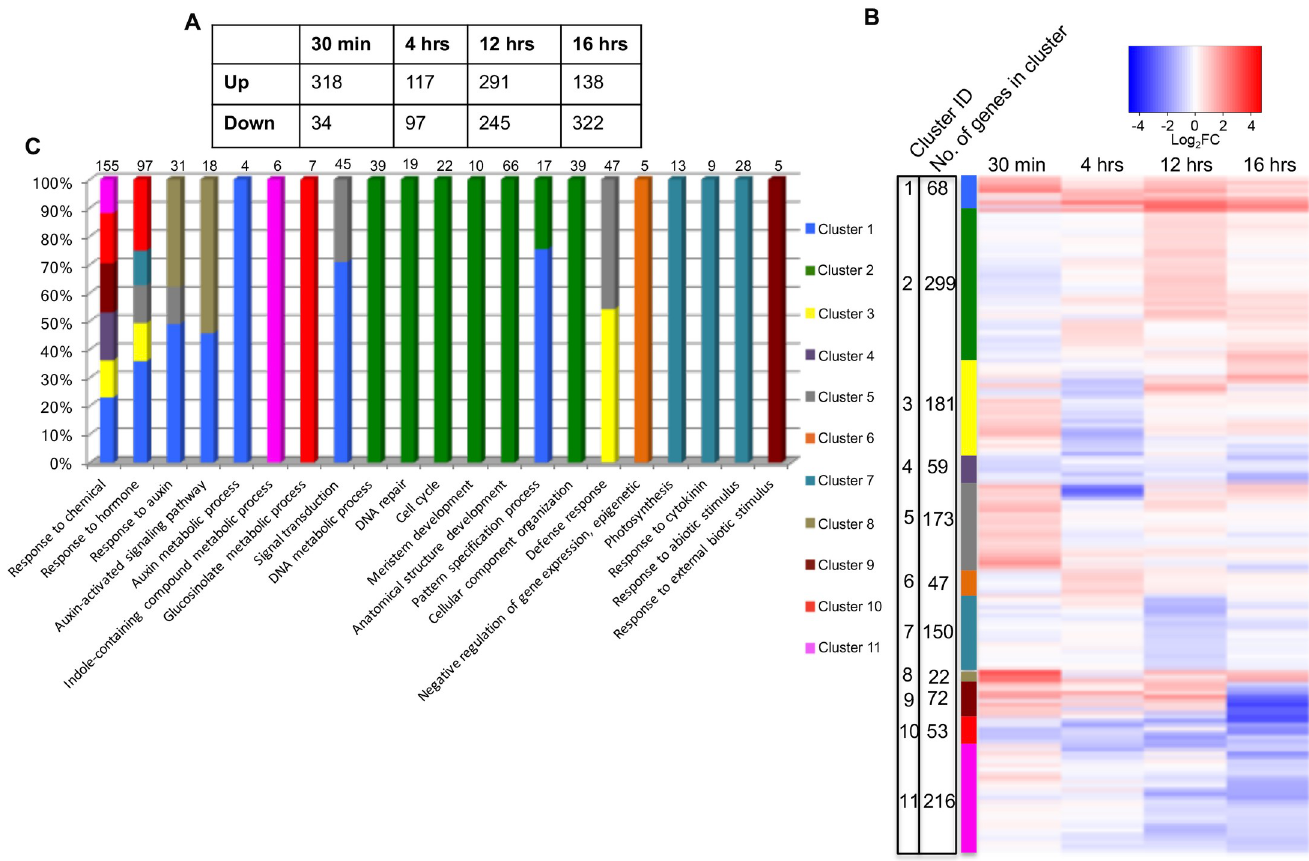
Fig 4. Identification of auxin-regulated genes in the Arabidopsis inflorescence meristem. (A) Summary of number of up or down regulated genes at various time points after auxin application to the pin1 SAM. (B) Hierarchical clustering of all genes differentially expressed in response to auxin. The genes clustered according to expression were divided into 11 manually selected clusters indicated by the cluster ID and color markings adjacent to the expression level columns. (C) Representation, as a percentage, of selected Gene Ontology (GO) terms amongst the clusters identified in Fig 5B. E.g. GO term “Defense response” is represented only in clusters 3 and 5, with each cluster containing approximately 50% of genes associated with this GO term. The total number of genes associated with each GO term is marked above each GO term column.